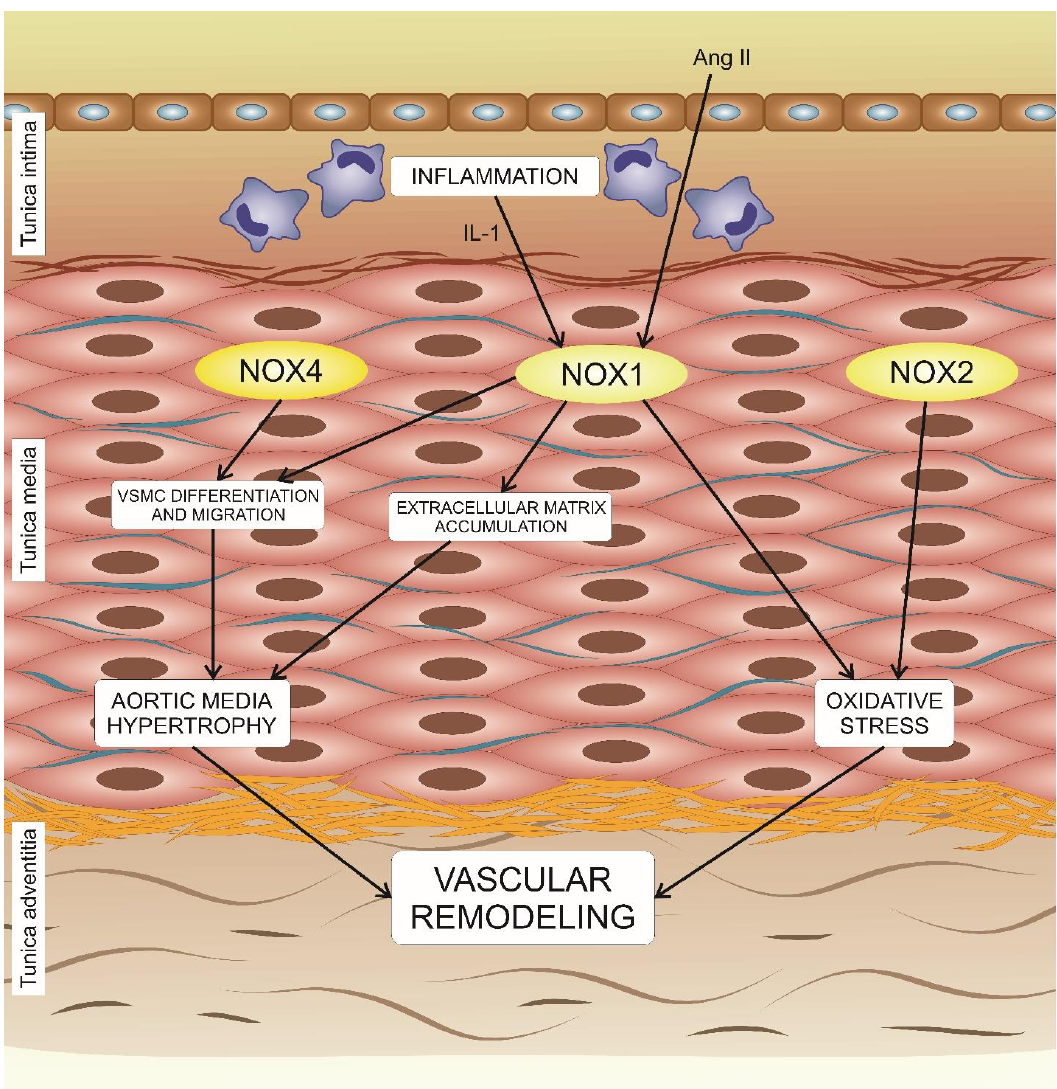
Figure 2. Role of NOX isoforms in vascular remodeling. Oxidative stress and hypertrophy of aortic media in response to angiotensin II (Ang II) signaling and inflammation are mediated by several isoforms of NOX and together lead to vascular remodeling processes.